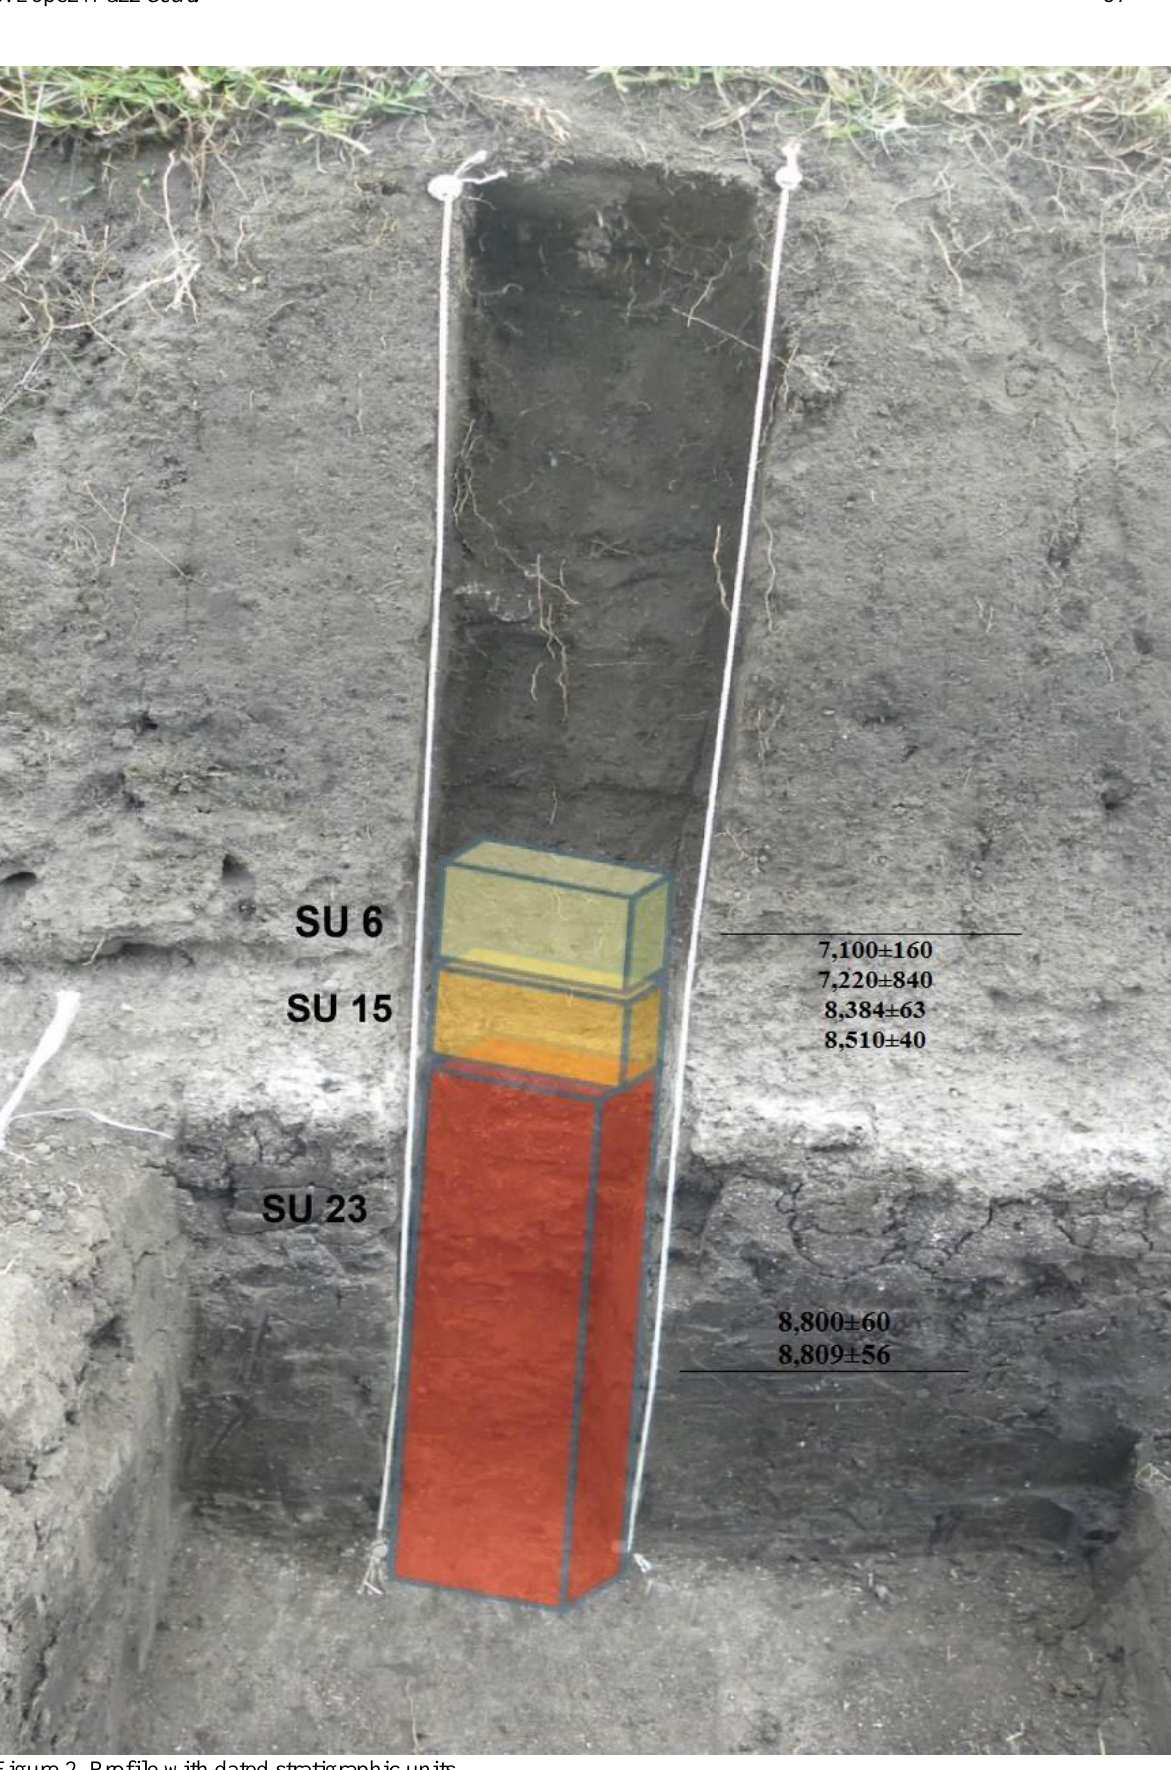
Figure 2. Profile with dated stratigraphic